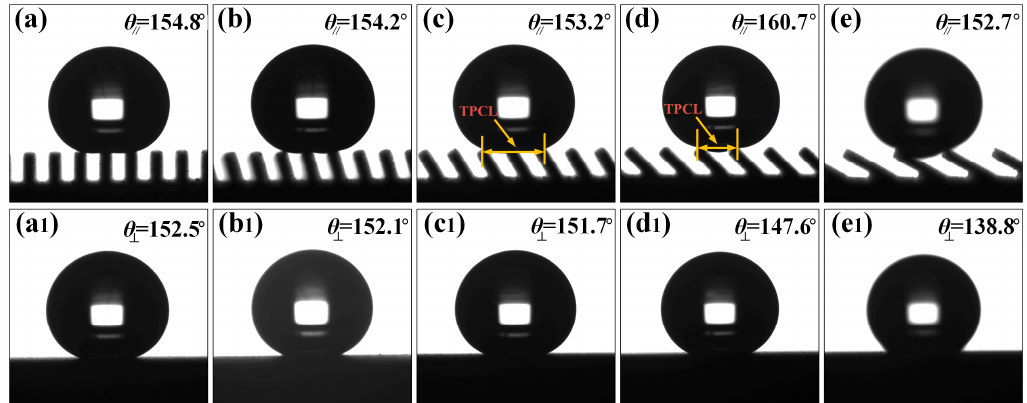
Figure 6. The contact angles of water droplets in the parallel and perpendicular directions at different inclination angles A of the groove ( L = 300µm): the direction parallel to groove ( a ) A = 90°, ( b ) A = 75°, ( c ) A = 60°, ( d ) A = 45°, ( e ) A = 30°; the direction perpendicular to groove ( a1 ) A = 90°, ( b1 ) A = 75°, ( c1 ) A = 60°, ( d1 ) A = 45°, ( e1 ) A = 30°.